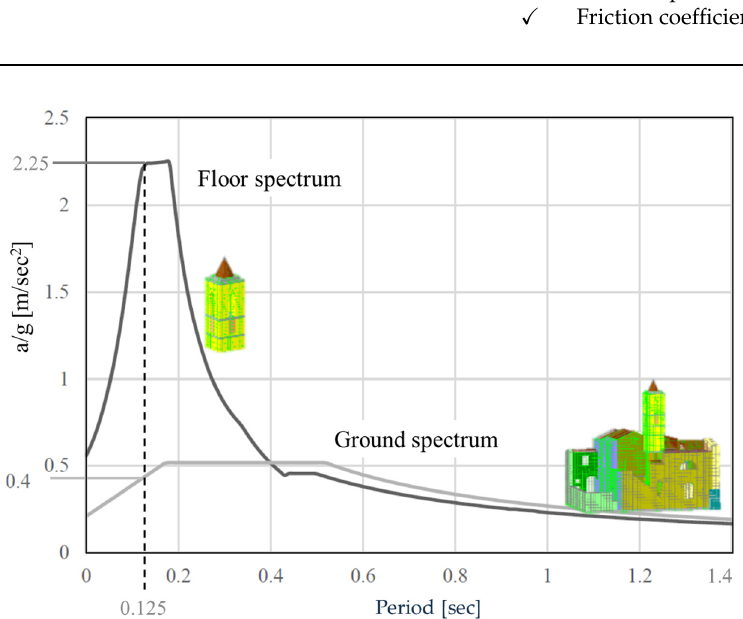
Figure 8. G round and fl oor spectra at the base of bell tower. Figure 8. Ground and floor spectra at the base of bell